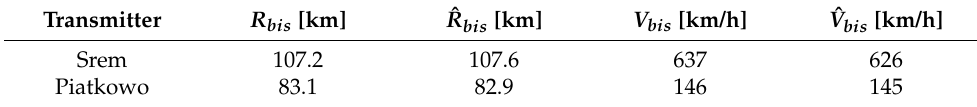
Table 3. Bistatic range and velocity measured for RYR2XJ plane. Transmitter